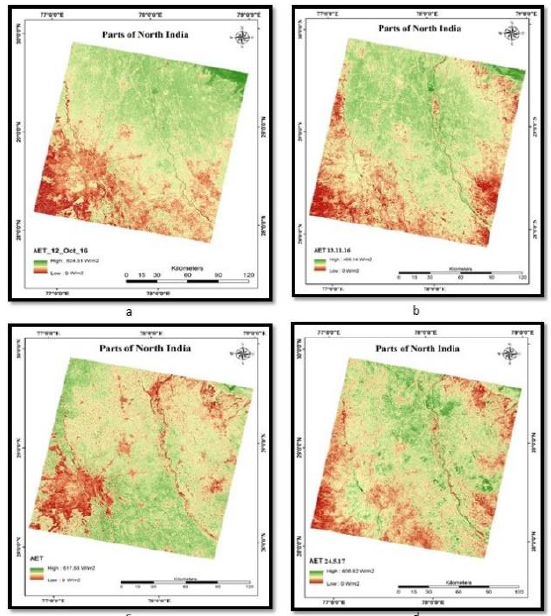
Figure 8. Latent Heat Flux a) 12/10/2016; b) 13/11/2016; c)